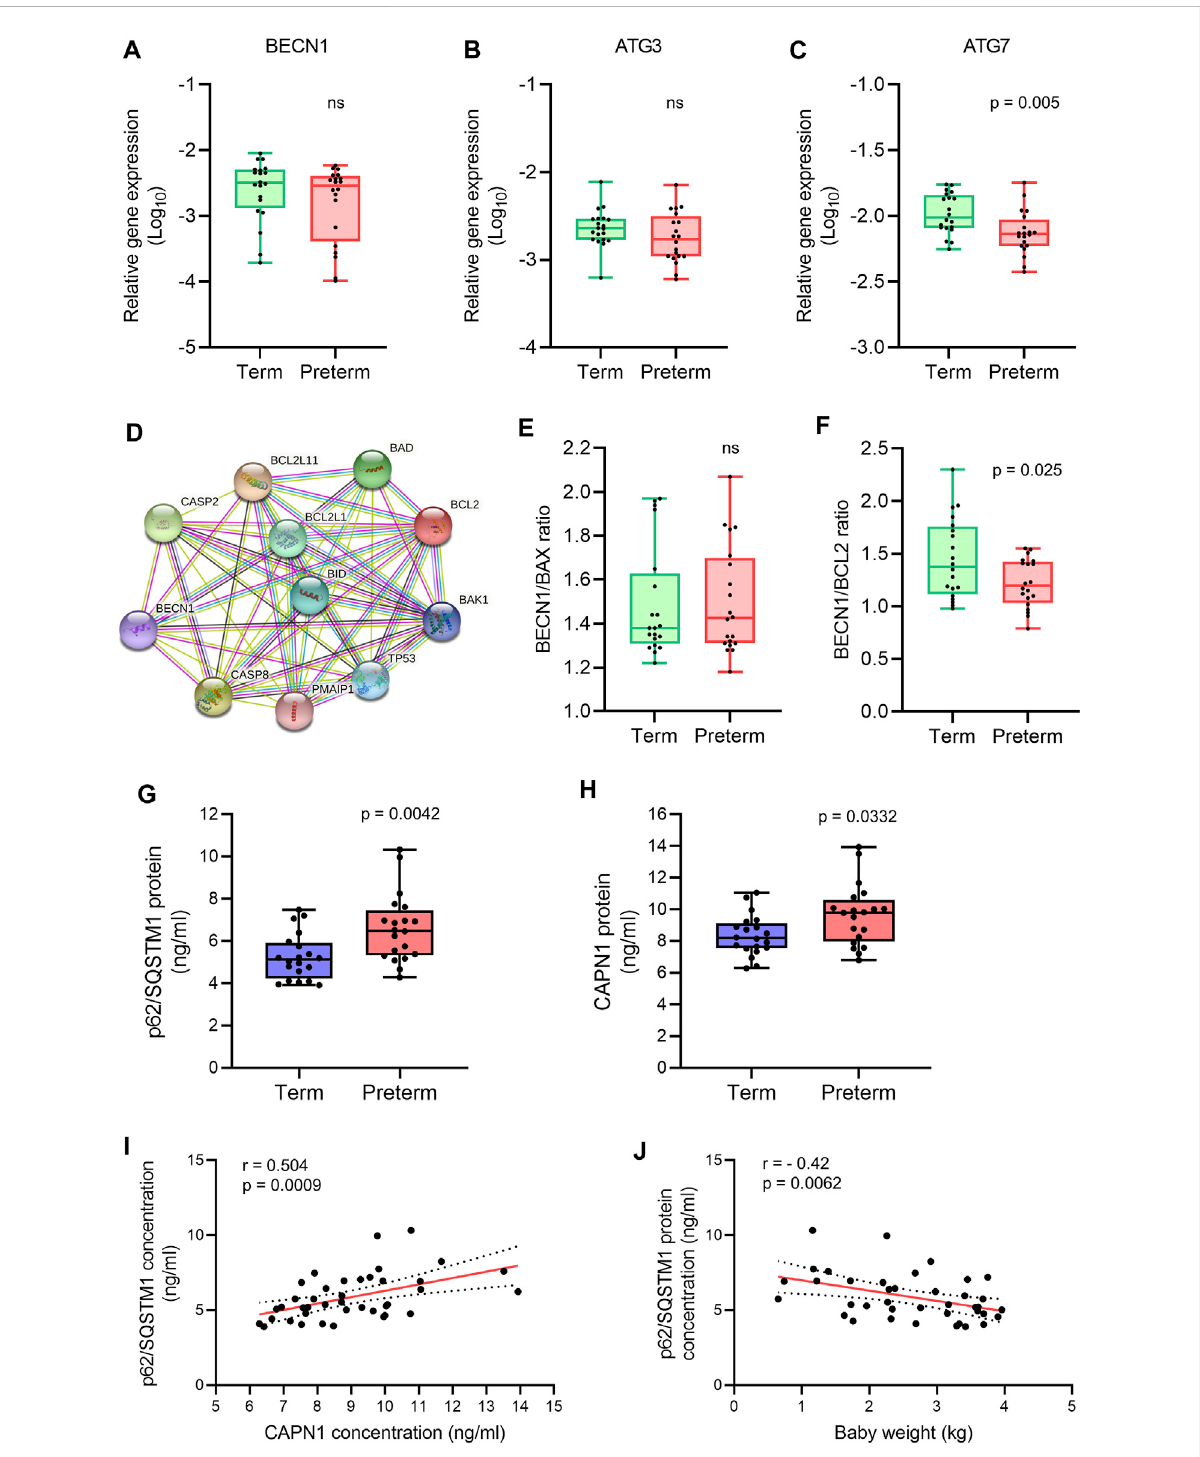
FIGURE 3 Autophagy gene and protein expressionanalysis. (A-C) Box plotsof qRT-PCR analysis showing gene expression (Relative to GAPDH ) of BECN1 , ATG3 and ATG7 in term and preterm placentas. n = 20 term and 20 preterm. Data are presented as median and IQR with minima and maxima. Each dotrepresentsindividualsubject.( D) STRINGprotein-proteininteractionanalysis(STRING,Version11.5). (E,F) Ratioofgeneexpressionof BECN1 and BAX (E),and BECN1 and BCL2 (F)intermandpretermplacentas.n=20termand20preterm.DataarepresentedasmedianandIQRwithminima and maxima ( G,H). Box plots showing ELISA assay of p62/SQSTM1 (G) and CAPN1 (H) on term and preterm villous placenta tissue lysates. Total protein load at 300 μ g/ml for each sample. n = 20 term and 20 preterm. Data are presented as median and IQR with minima and maxima. (I) Spearman Rank test correlation analysis between p62/SQSTM1 and CAPN1 protein concentrations on the entire cohort (n = 40). J. Spearman Rank test correlation analysis between p62/SQSTM1 protein concentrations and baby birth weights on the entire cohort (n = 40). Dotted lines represent 95% CI bands of the best- fi t lines (Solid). ns = not signi fi cant, Mann-Whitney U test (A –